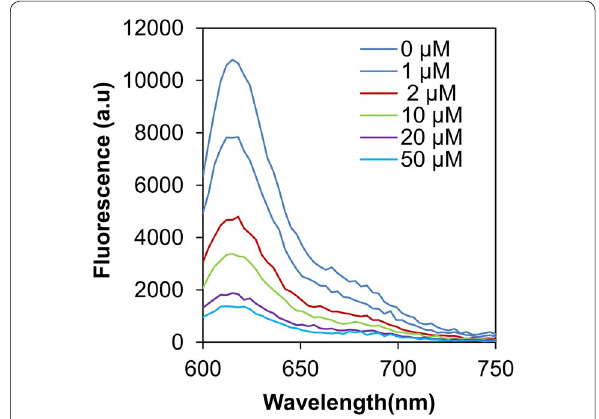
Fig. 3 Fluorescence spectra of GO-DNA mixture. DNA was irradiated by UVB light for 20 min in various concentration of